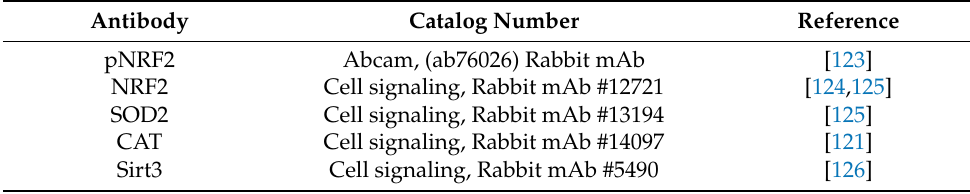
Table 1. Primary antibodies used for protein expression.